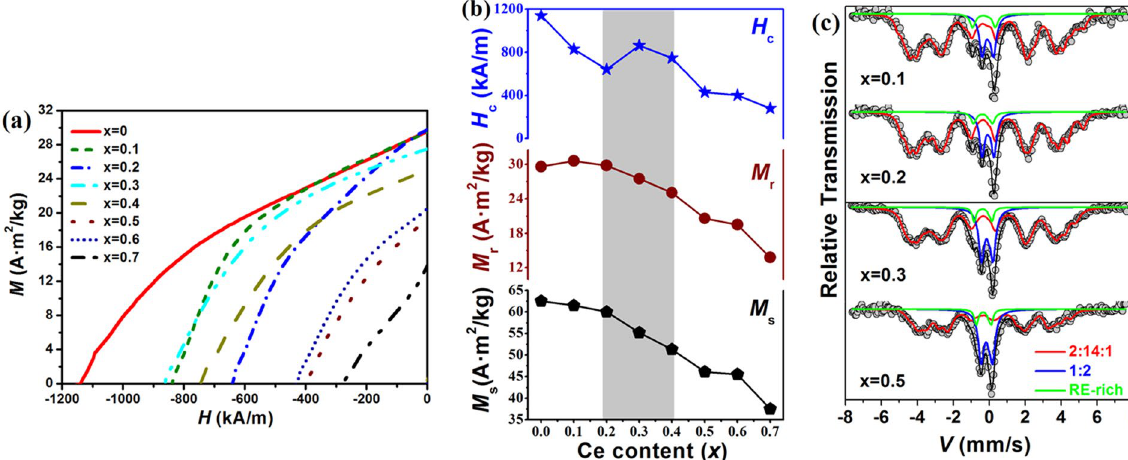
Figure 4. The demagnetization curves ( a ) and magnetic properties ( b ) for the as-cast (Nd 1 − x Ce x ) 25 Fe 40 Co 20 Al 4 B 11 alloys, and Mössbauer spectra at 300 K for the selected as-cast (Nd 1 − x Ce x ) 25 Fe 40 Co 20 Al 4 B 11 alloys ( c ).